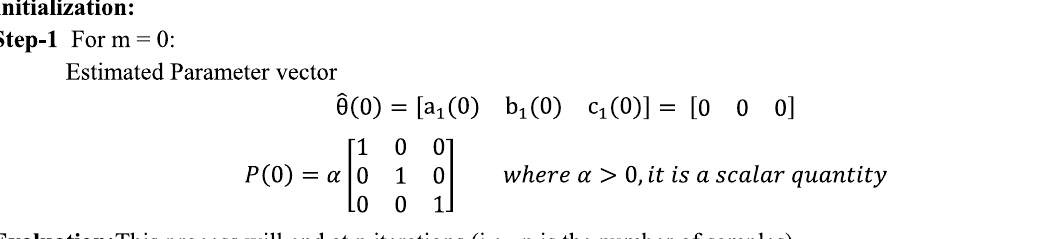
Table 6 Stepwise execution of FF-RLS